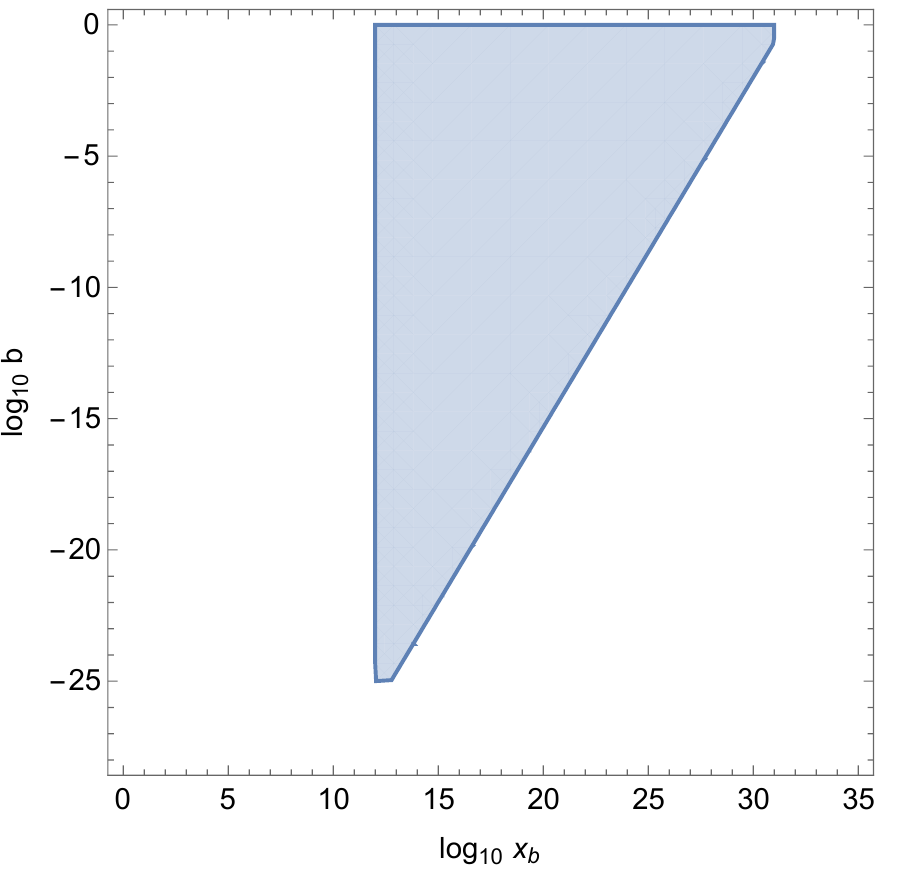
Figure 2. Region of stability under vector perturbations in parameter space for the bouncing models considered. The colored area represents the values of b and x b which satisfies the consistency conditions (109) and